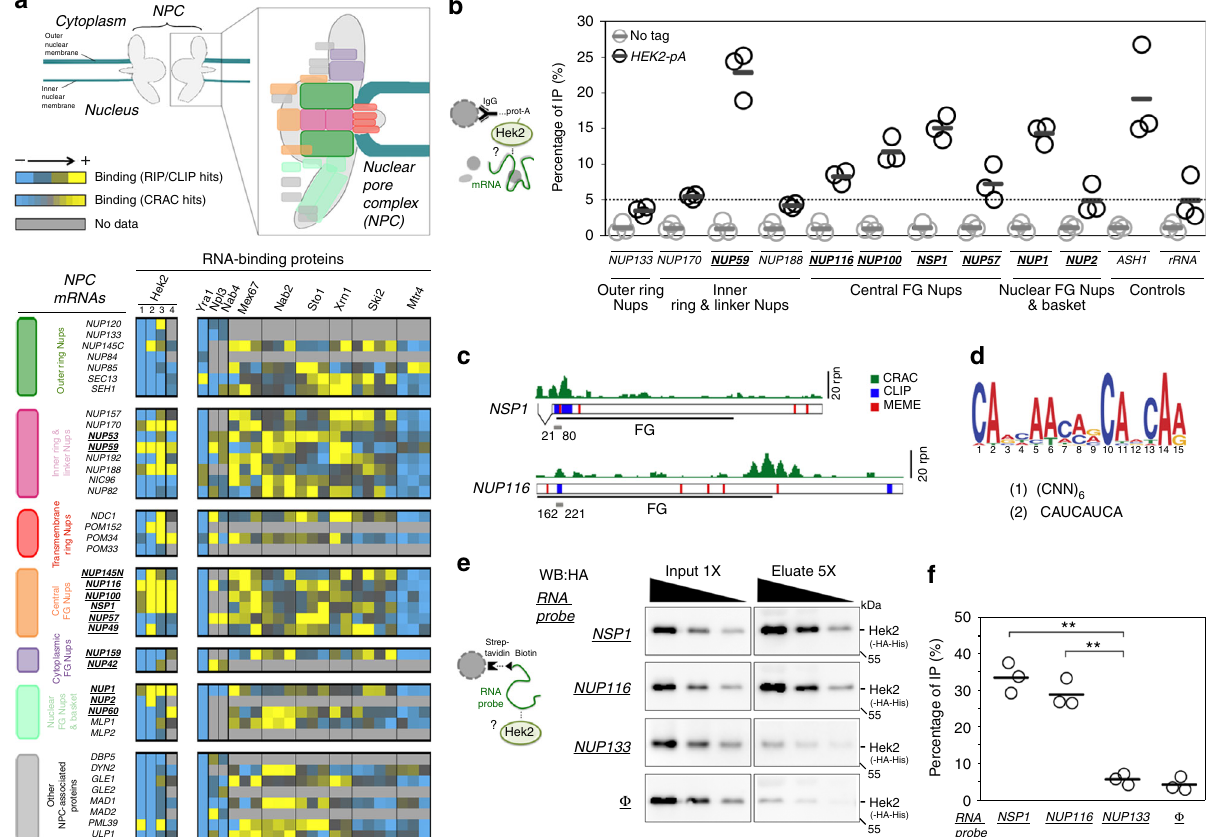
Fig. 1 The hnRNP K-like protein Hek2 speci fi cally associates with a subset of NPC mRNAs. a Top, Representation of the yeast nuclear pore complex (NPC), showing subcomplexes as colored boxes. Bottom, mRNAs encoding NPC components are sorted by subcomplexes and the strength of their association to the different indicated RNA-binding proteins (RBP) is represented by a color code, as scored in distinct RIP, CLIP or CRAC datasets. Bright yellow indicates the preferred association of a given mRNA to the RBP of interest. For Sto1, Mtr4, Nab2, Mex67, Xrn1 and Ski2, multiple repetitions are displayed 27 . For Hek2, the results from independent studies are represented: (1) 24 , (2) 26 , (3) 25 , (4) 27 . FG-Nups appear in bold, underlined. The NUP145 mRNA gives rise to both Nup145-N and Nup145-C nucleoporins and is displayed for each of the according subcomplexes. b Hek2-pA-associated mRNAs were immunopuri fi ed and quanti fi ed by RT-qPCR using speci fi c primer pairs. Percentages of IP are the ratios between puri fi ed and input RNAs, normalized to the amount of puri fi ed bait and set to 1 for the “ no tag ” . Means and individual points ( n = 3) are displayed. A schematic representation of the assay is shown. c Overview of Hek2-binding sites on NSP1 and NUP116 mRNAs. The number of CRAC hits (rpn (reads per nucleotide)) 27 , the position of CLIP fragments 26 and the occurrences of the binding site found by the MEME analysis are indicated. The positions of the FG-coding region and of minimal Hek2-binding sites used for in vitro pull down (in gray) are represented. The broken line indicates the NSP1 intron. d MEME result from NUP59 , NUP116 , NUP1 , NSP1 and NUP100 sequences. (1, 2): previously identi fi ed Hek2-binding sequences 24,26 . e Left, Schematic representation of the assay. Recombinant HA-tagged Hek2 was incubated with streptavidin beads either naive ( Φ ) or coated with biotinylated RNA probes encompassing Hek2-binding sites from NSP1 (21 – 80) or NUP116 (162 – 221) or a sequence from NUP133 (1429 – 1488) . Right, Decreasing amounts of input and eluate fractions were loaded for quanti fi cation. f Percentages